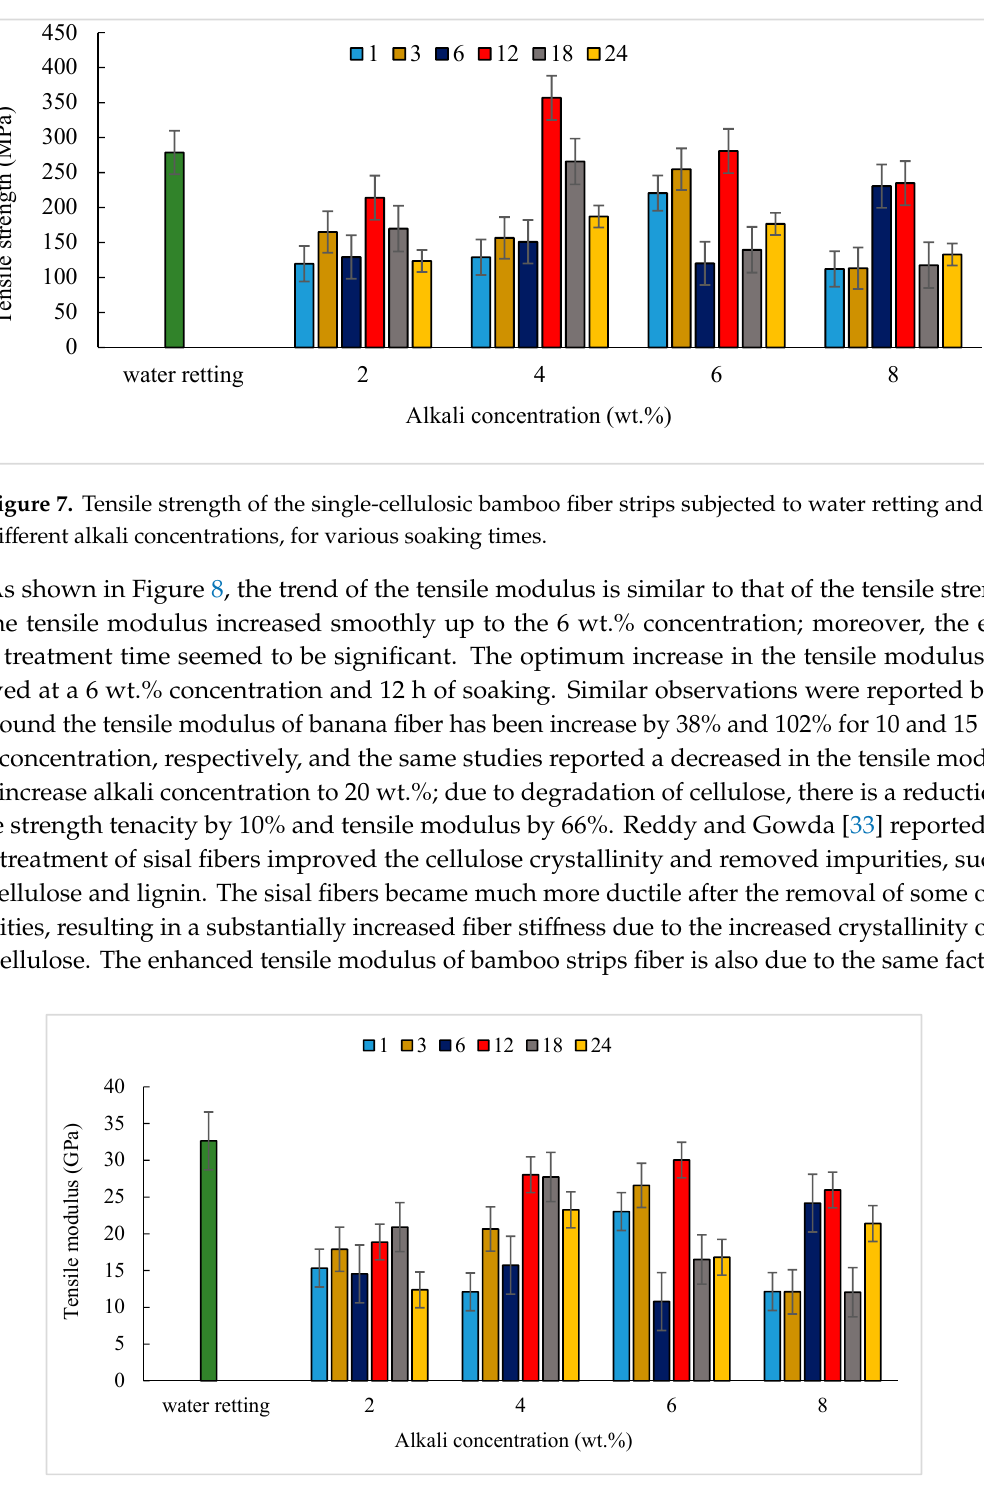
Figure 8. Tensile modulus of single-cellulosic bamboo fiber subjected to water retting and di ff erent alkali concentrations for various soaking